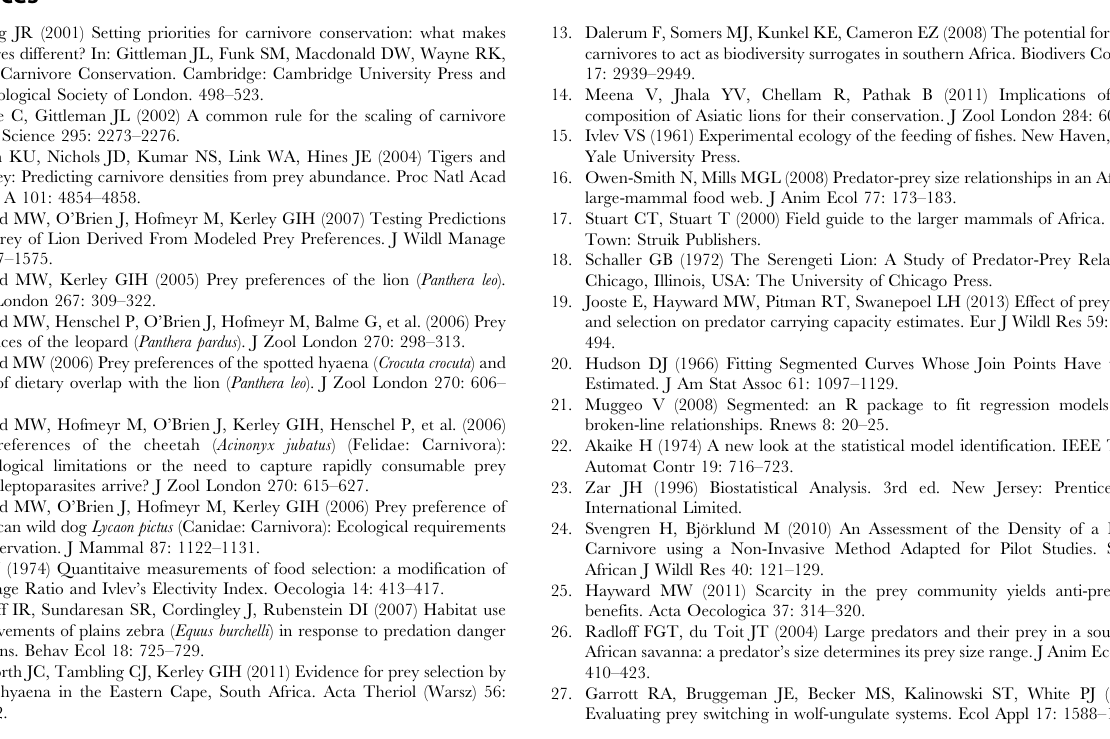
ranges of cheetah, leopard, lion, spotted hyaena and wild dog. Table S2 Prey species masses, mass-ranks and mean Jacob’s Index (J.I.) values used in segmented model analyses. (XLSX) Table S3 Details of carnivore kill and prey abundance data used to test preferred and accessible prey weight ranges. The sources, location and timing of African studies, and the number of kills recorded in each, used to assess the mean percentage of the diet accounted for by the preferred and accessible prey weight ranges determined in this study. (XLSX) Code S1 Code used to generated segmented linear relationships using the segmented generalized linear function in the segmented package [21] of the open source statistical program R (R Development Core Team 2012).